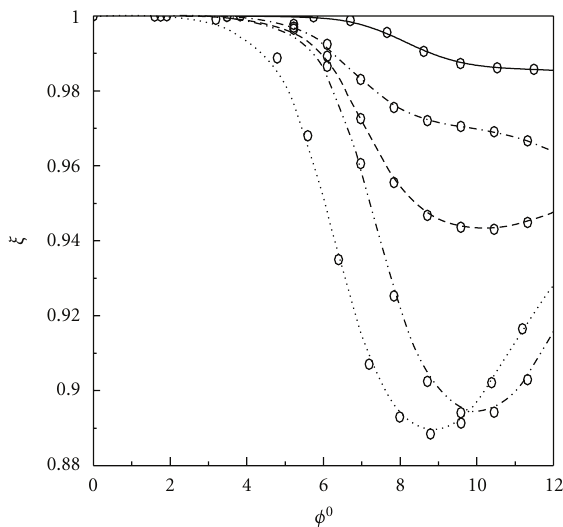
Figure 16: The distribution of dimensionless current at particular X coordinates of the catalyst layer T = 333 K, c 0 M = 1 . 0 M, l = 10 μ m, a = 1 . 0 × 10 5 m − 1 , E 0 = 0 . 4V, κ e = 3 . 4 Ω − 1 m − 1 , D e =